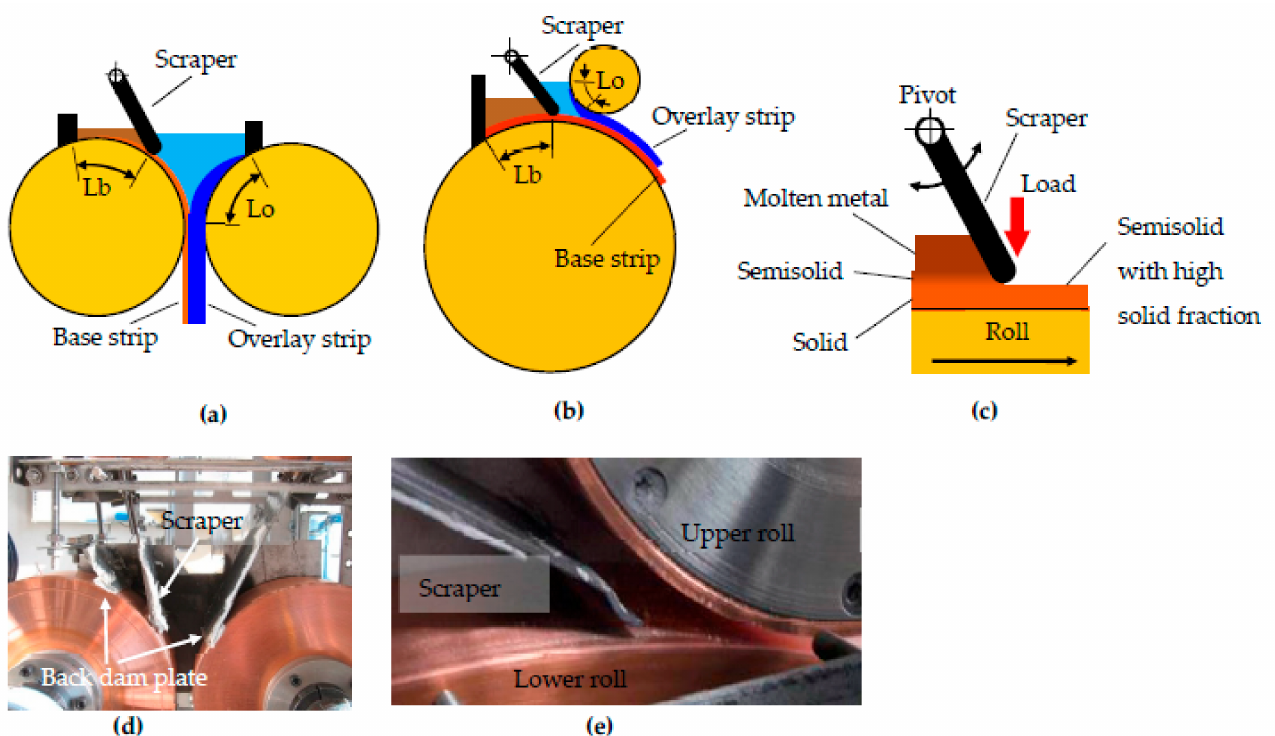
Figure 21. Schematic illustrations of two types of twin-roll casters equipped with a scraper, and enlarged view and photographs of the scraper. ( a ) Vertical-type twin roll caster equipped with a scraper. ( b ) Unequal-diameter twin roll caster equipped with a scraper. ( c ) Enlarged view of the scraper. ( d , e ) Close-up photographs near scrapers of type ( a ) and type ( b ), respectively. Lb: solidification length of a base strip; Lo: solidification length of an overlay